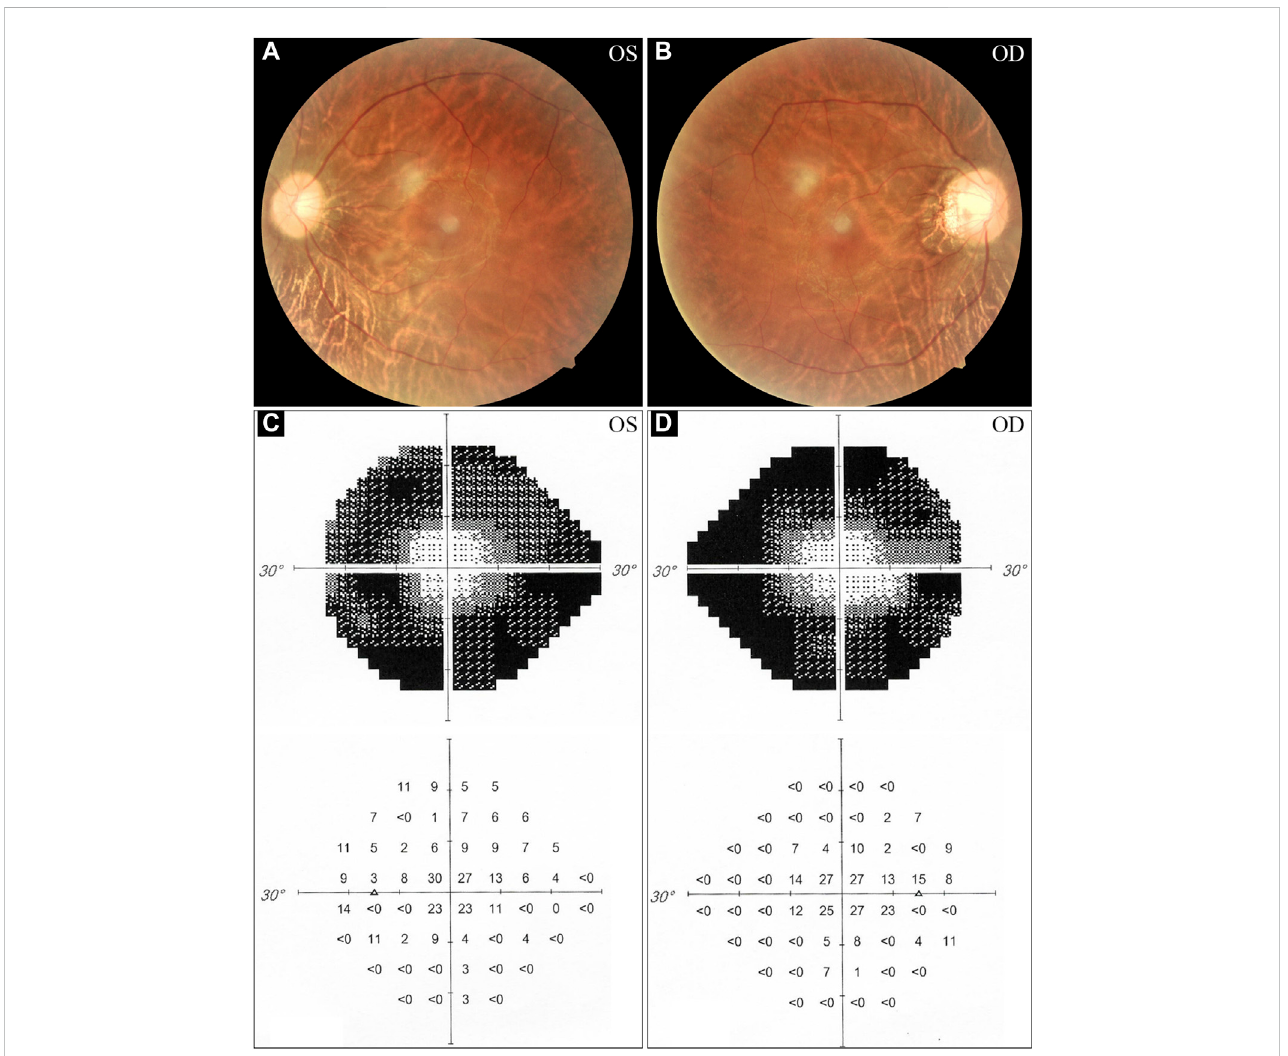
FIGURE 1 Fundus photographs and visual fi eld tests from the proband. (A, B) The fundus examinations demonstrate pigmentary deposits, attenuated vessels, and waxy optic discs. (C, D) Visual fi eld assessments reveal peripheral vision loss in the proband. OS, oculus sinister (left eye); OD, oculus dexter (right eye).